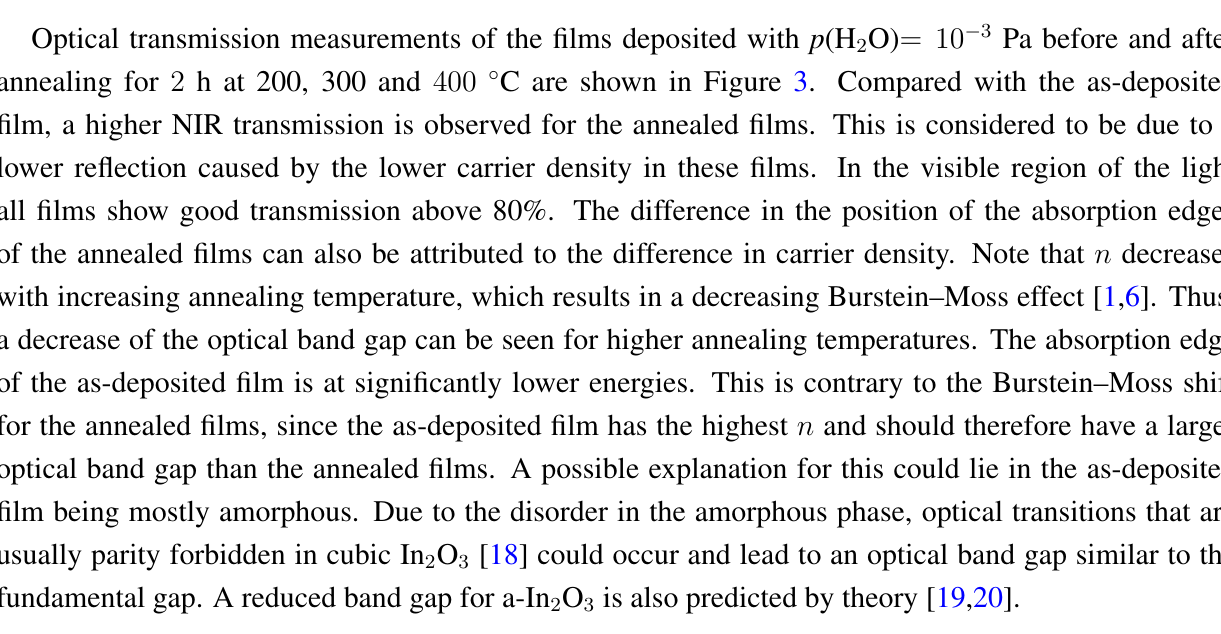
O :H films deposited with 1 . 0 × 10 − 3 Pa H 2 3